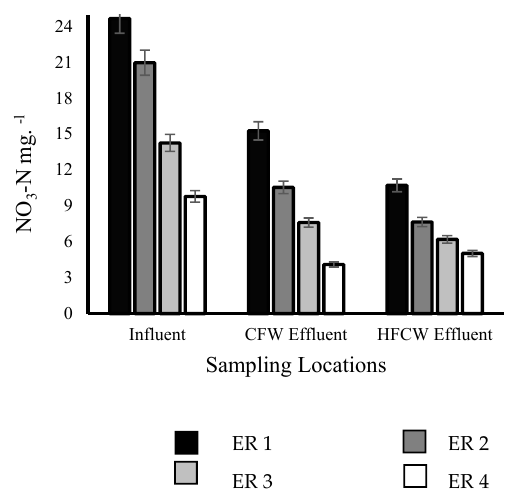
Figure 4. NO 3 –N concentration during different experimental runs in the second setup.